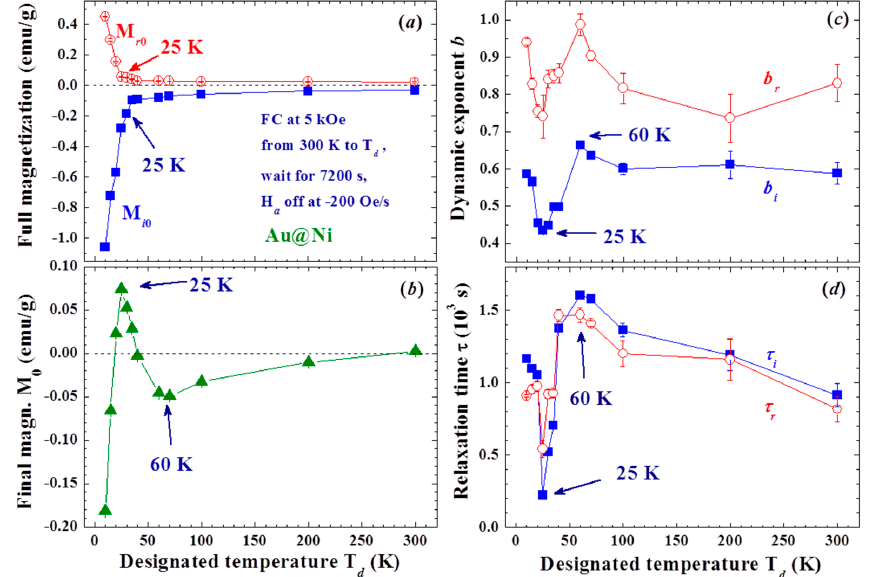
Figure 9. ( a ) variations of full residual magnetization M r0 and full induced magnetization M i0 with T d ; ( b ) variations of final magnetization M 0 after long relaxation with T d ; ( c ) variations of dynamic exponents of residual magnetization b r and induced magnetization b i with T d ; and ( d ) variations of relaxation time of residual magnetization τ r and induced magnetization τ i with T d .